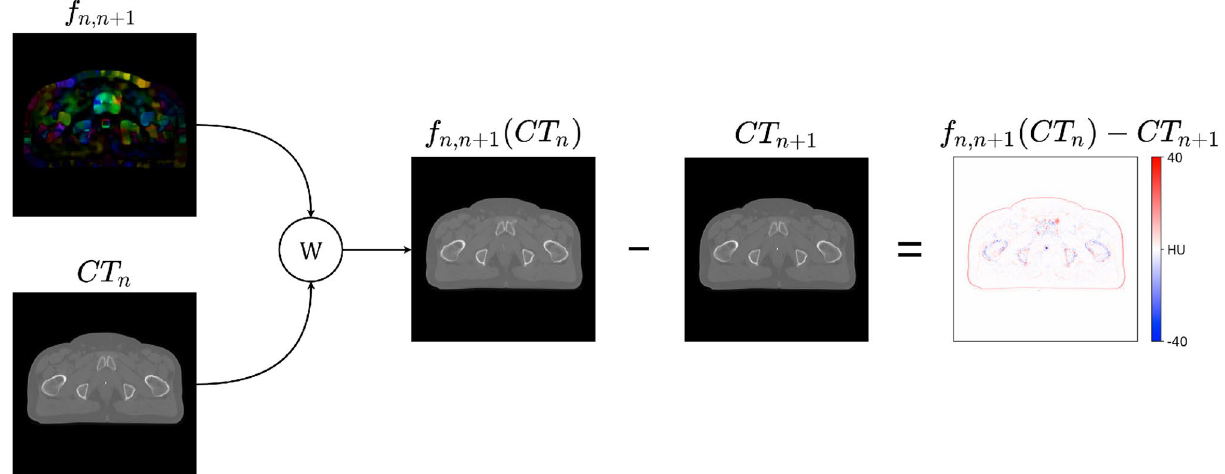
Figure 2. The warping of CT image from current to next slice using the flow